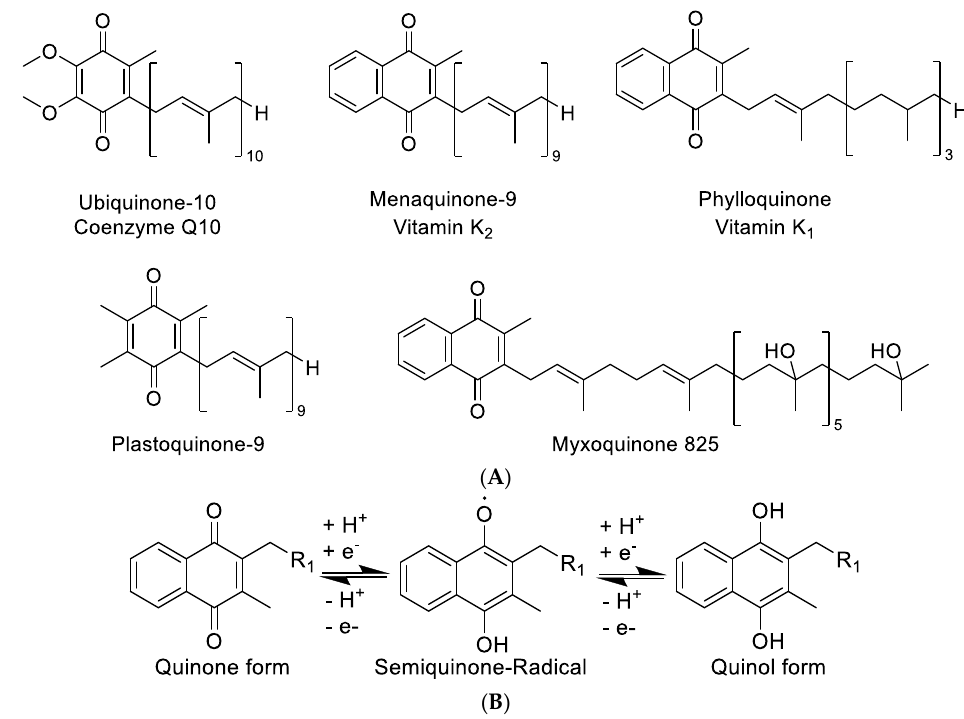
Figure 1. ( A ) Structure overview of ubiquinone, menaquinone, phylloquinone, plastoquinone, and the new myxoquinone-825. ( B ) Quinone and quinol form of naphthoquinone type metabolites.